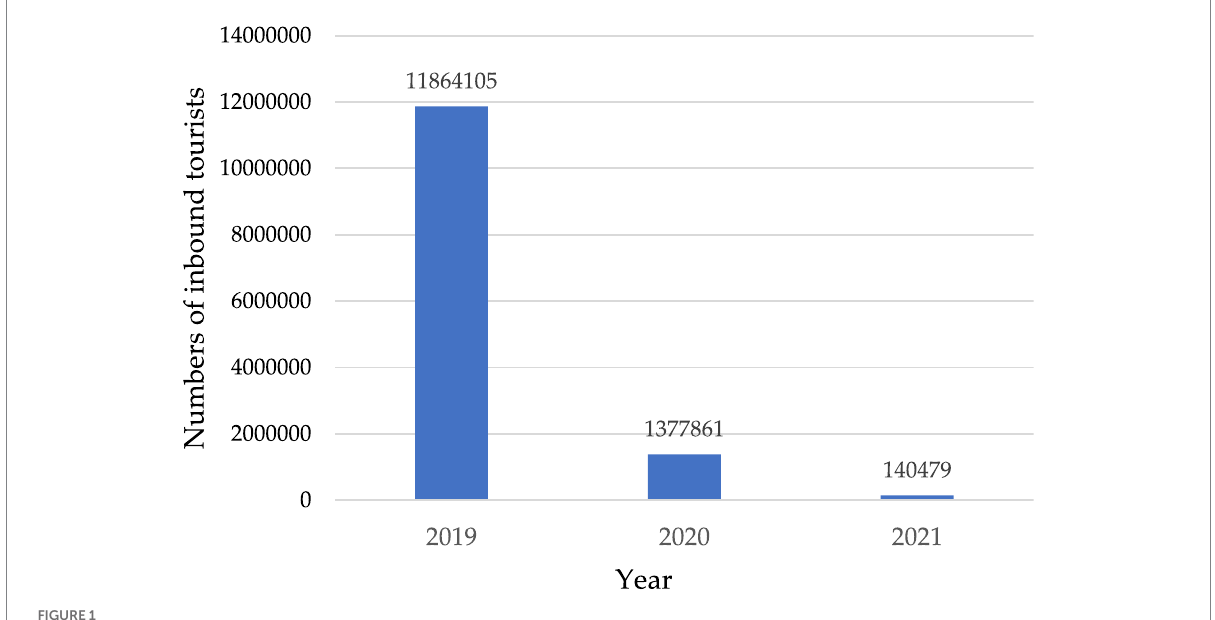
FIGURE 1 The distribution of inbound tourists from 2019 to 2021 (Taiwan Tourism Bureau,